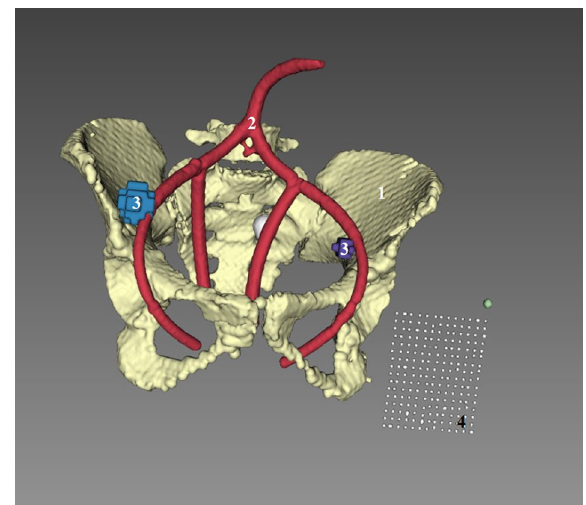
Fig. 5 Results of the segmentation process, after registration. Segmentation of CT images with 3D reconstruction of pelvic structures (pelvic bones (1), arteries (2), lymph nodes (3), and calibration device (4). CT, computed